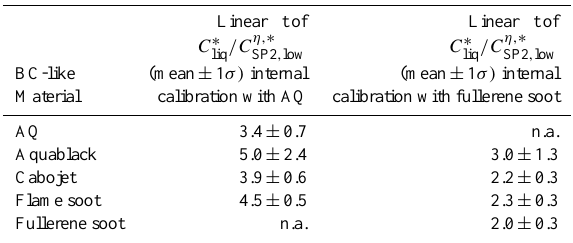
Table 1. External calibration factor ( C ∗ determined by using various BC-like materials. n.a. stands for not